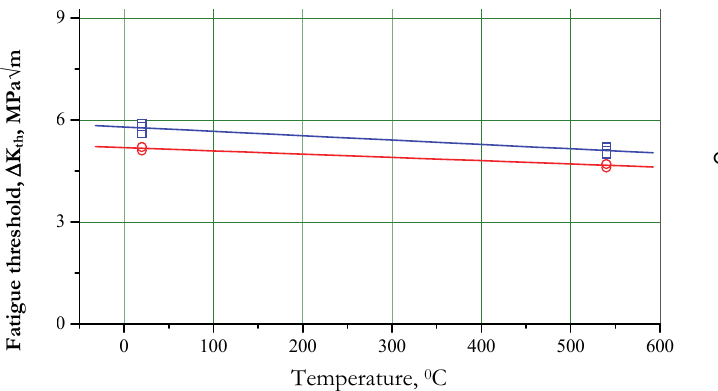
Figure 3: Fatigue threshold Δ K th vs. temperature in PM